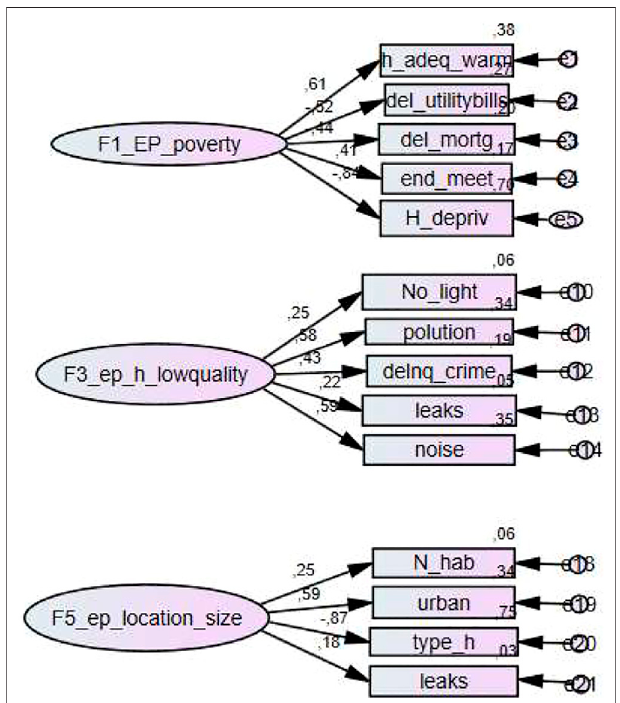
FIGURE 1 | CFA estimation of three EP factor